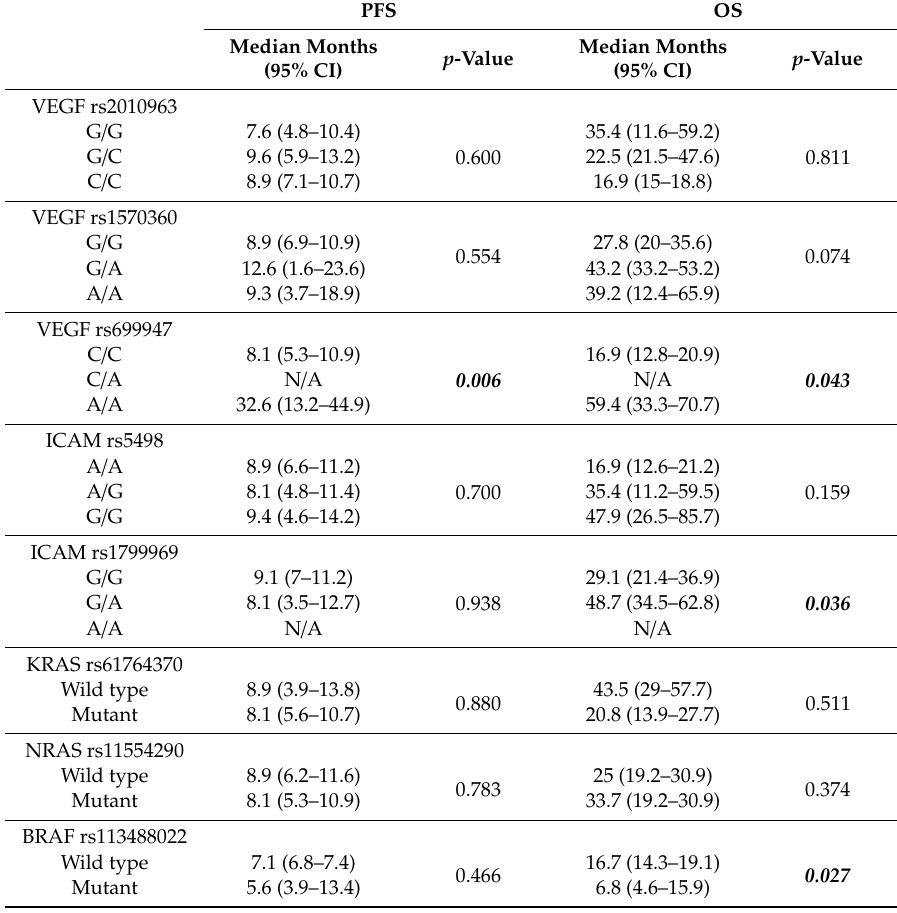
Table 3. Analysis of the polymorphisms for progression-free survival (PFS) and overall survival